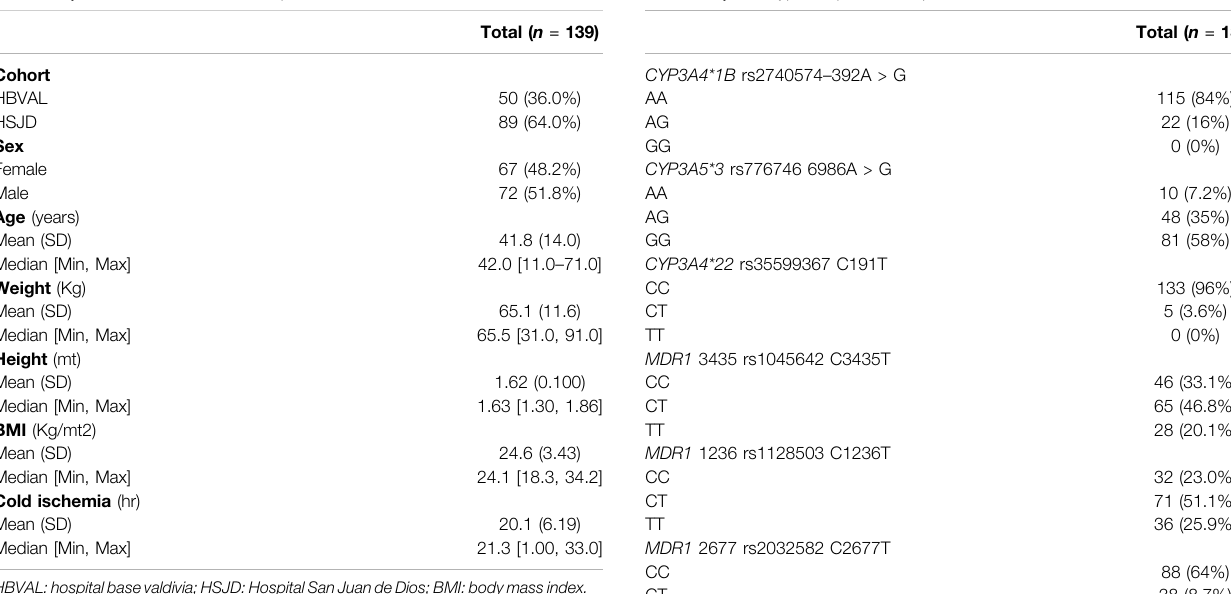
TABLE 1 | Baseline characteristics of patients. TABLE 2 | Genotype frequencies of